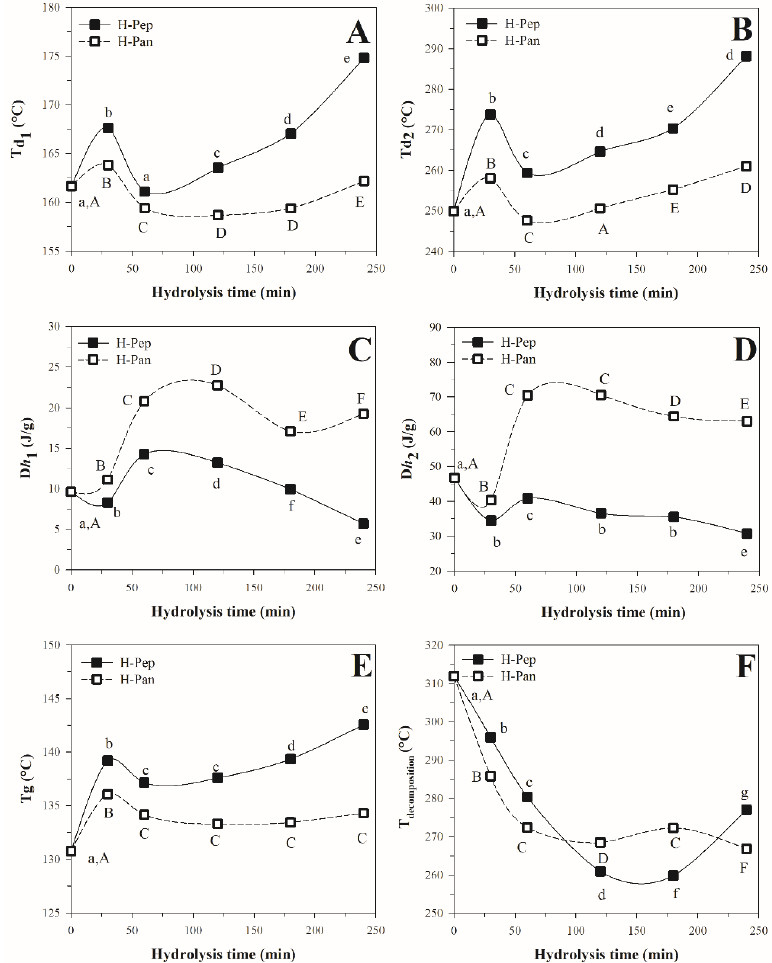
Figure 3 Thermal properties of leaf protein concentrate (LPC) and its hydrolysates. ( A ) and ( B ) show the denaturation temperature (T d ), while ( C ) and ( D ) the denaturation enthalpy (Δ h ) corresponding to the first (Td 1 and Δ h 1 ) and second (Td 2 and Δ h 2 ) endothermic peak, respectively. ( E ) and ( F ) are the glass transition temperature (Tg) and decomposition temperature of LPC and protein hydroly- sates as a function of time, respectively. Different letters in the same treatment indicate a significant difference ( p < 0.05) with respect to time. 3.3.2. Differential Scanning Calorimetry Analysis DSC provides information on the structural stability of a protein based on the endo- thermic and exothermic events [37] . The Δ h represents the enthalpy changes that occur during the denaturation process and reflects the extent of the ordered secondary structure of a protein [38], while T d is a measurement of its thermal stability. After this temperature, irreversible changes occur in the structure of the protein. A higher T d value is associated